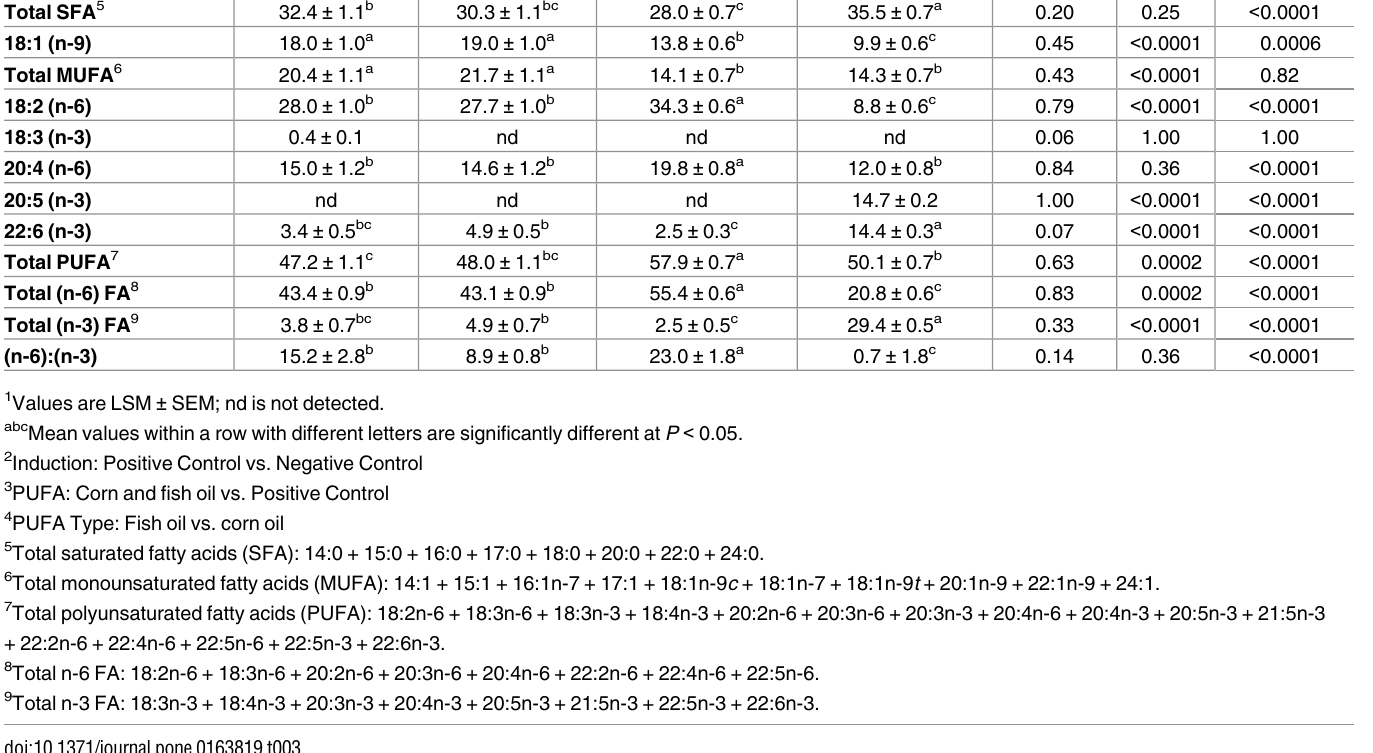
Table 3. Plasma concentrations (g/100 g FA) of selected FA in mice after dietary intervention for 12 weeks 1 . Fatty Acid (g/100 g FA)